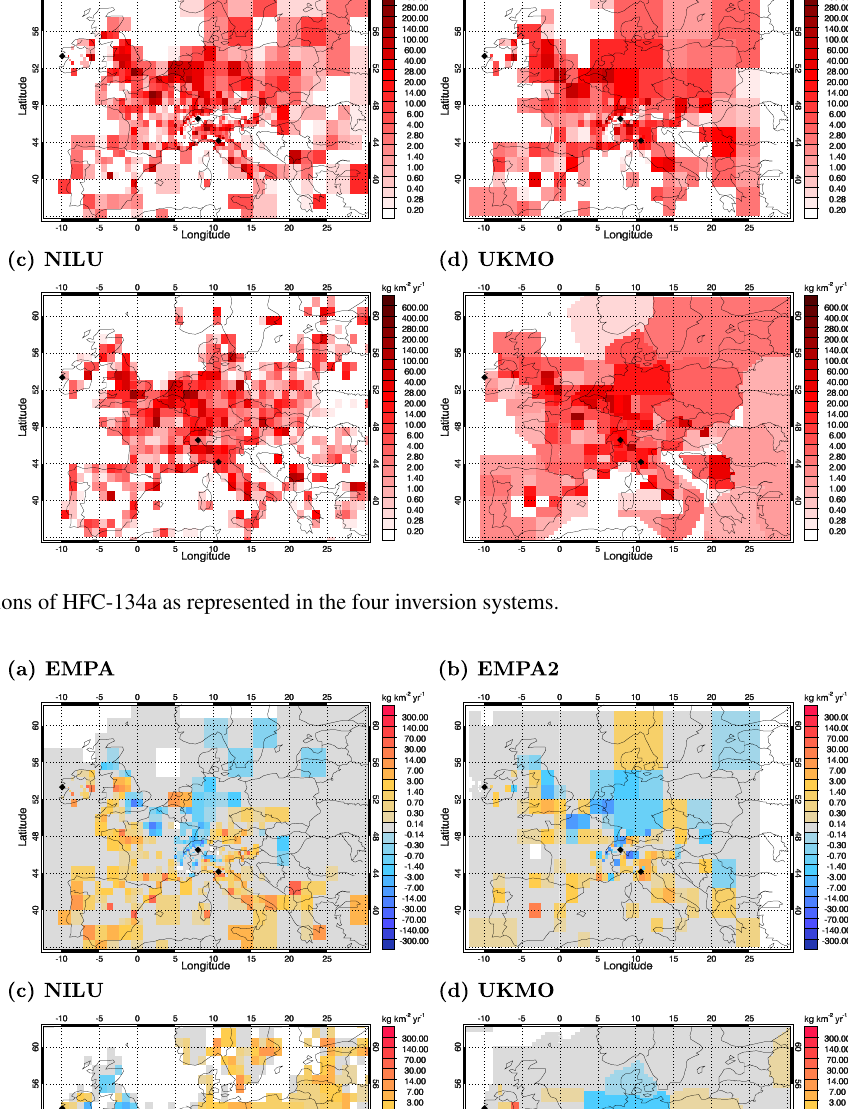
spatial error correlations. Minor maxima coincide with grid cells with large prior